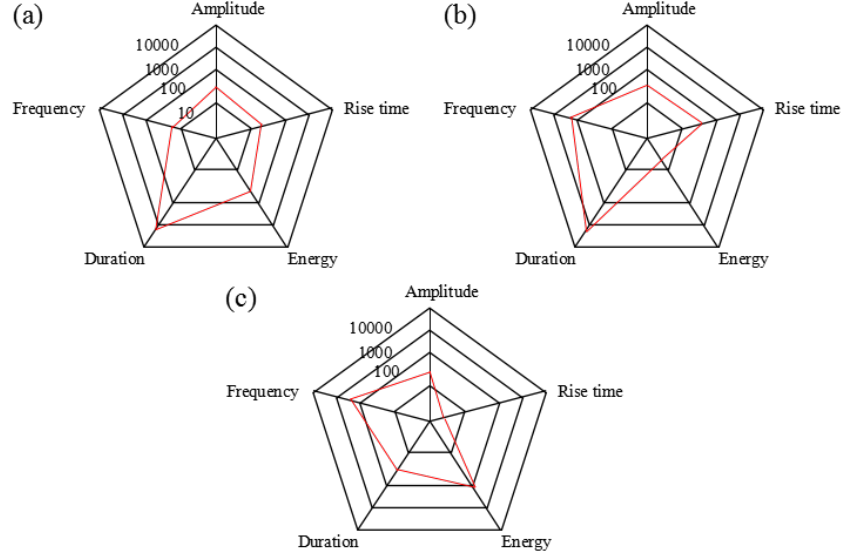
Figure 11. Average properties of three clusters with regard to the five AE parameters. ( a ) Class CL-1, ( b ) CL-2, and ( c ) CL-3.